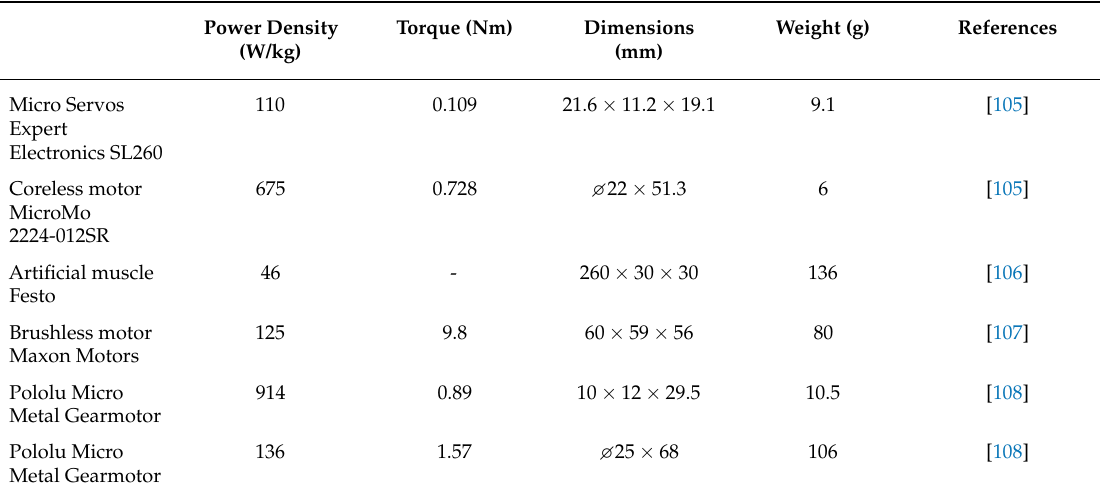
Table 2. Characteristics of conventional bionic orthosis